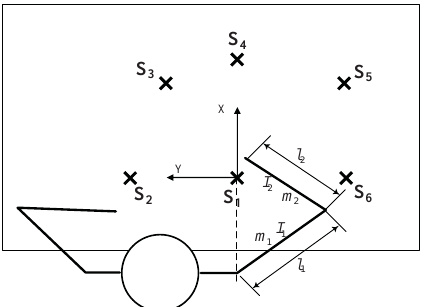
Figure 2: Experimental board with coordinate system and 6 points performed as targets to be reached by human subjects with forefinger-